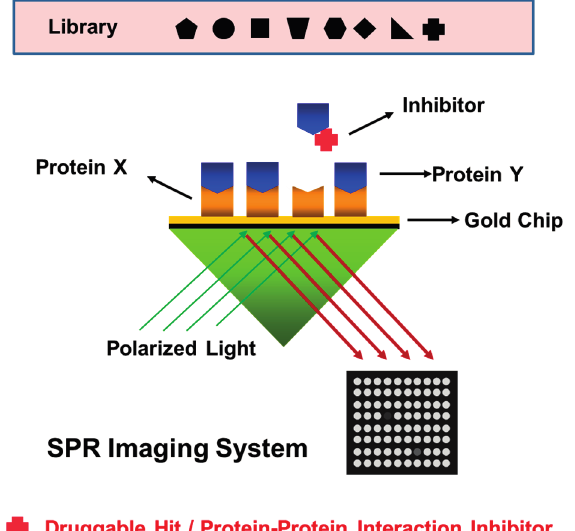
Figure 3. High-throughput drug screening using an SPR imaging protein chip system. The bright image indicates protein-protein interaction on a gold surface. Upon the binding of an inhibitor to the target protein, protein-protein interactions are disrupted, resulting in changes in SPR imaging signal intensity and a darker image. Adapted from